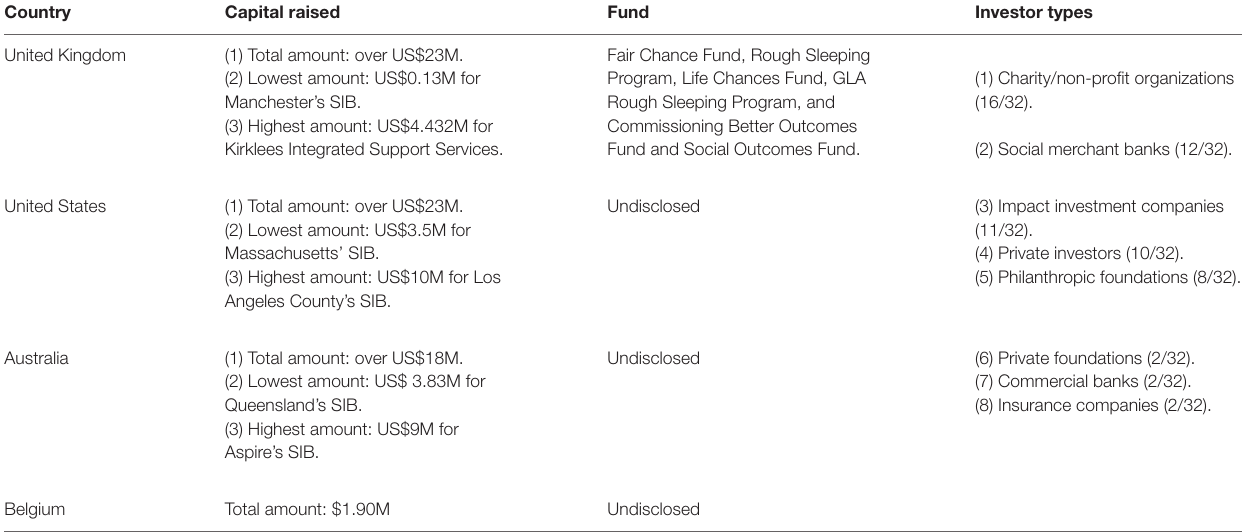
TABLE 3 | Investment in SIBs for